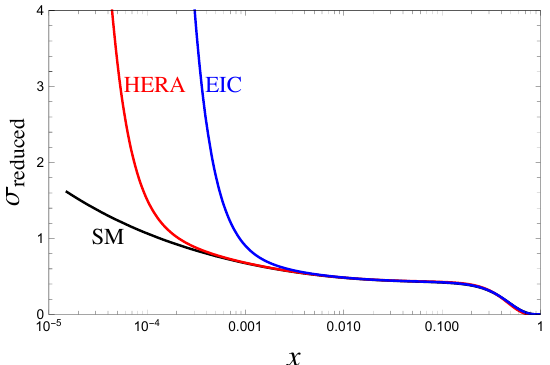
Figure 3 . Comparison at (cid:12)xed Q 2 = 2 GeV 2 of the reduced cross sections of the leading SM contribution, of HERA at energies E e = 27 : 5 GeV, E p = 920 GeV, and of the EIC at energies E e = 20 GeV, E p = 100